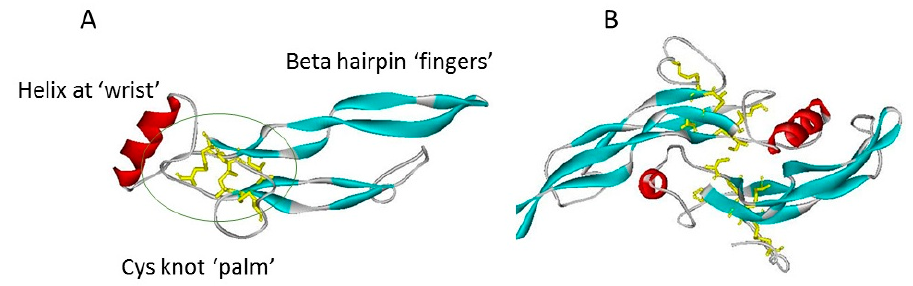
Figure 1. The TGF- β superfamily cystine knot fold, as typified by TGF- β 1 (co-ordinates from 1KLC.pdb). Protein chains are shown in ribbon format: β -strands are blue, helices red, turns green; cystines are shown in yellow stick format. ( A ) TGF- β 1 monomer showing the “hand” structures, with the cystine knot indicated by a green ellipse. ( B ) TGF- β 1 dimer, the “wrist” of each hand is cupped in the other subunit. The view of the dimer is rotated by 90° with respect to the plane of 1A. The interchain disulphide bridge is visible in the centre of the structure.